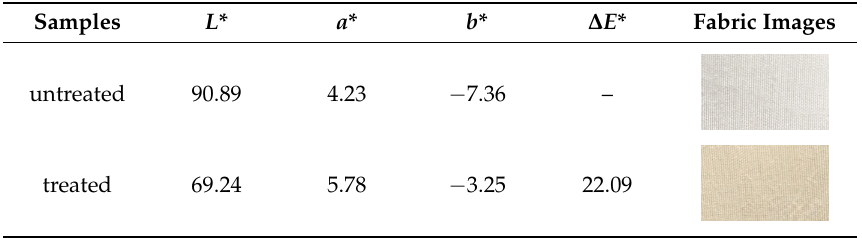
Table 4. Color coordinates of untreated and SS-AgNP treated silk fabric.